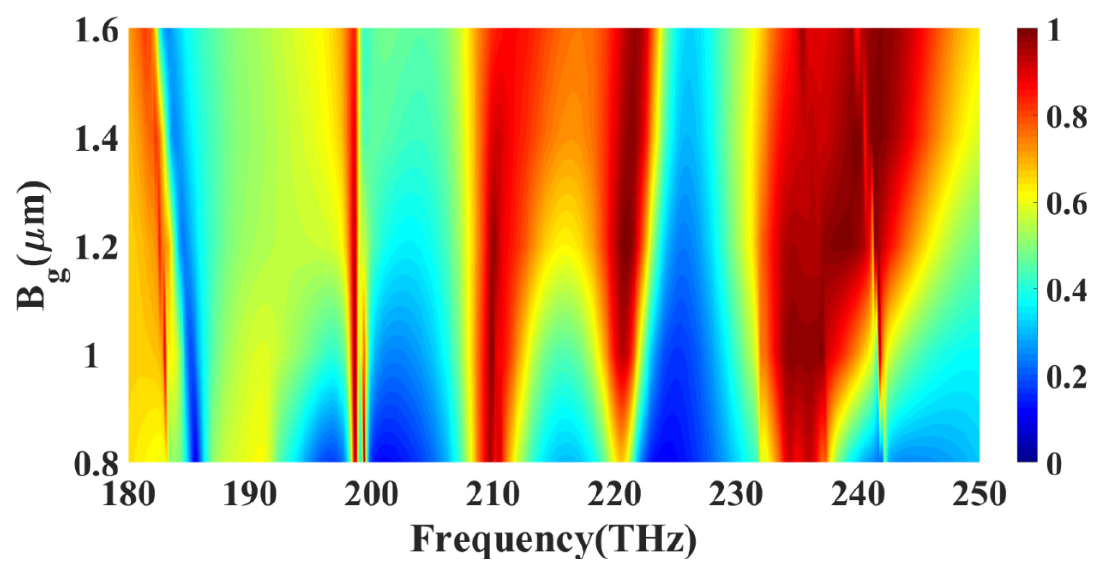
Figure 5. Calculated absorption response for the different size values of the borophene squared patch.